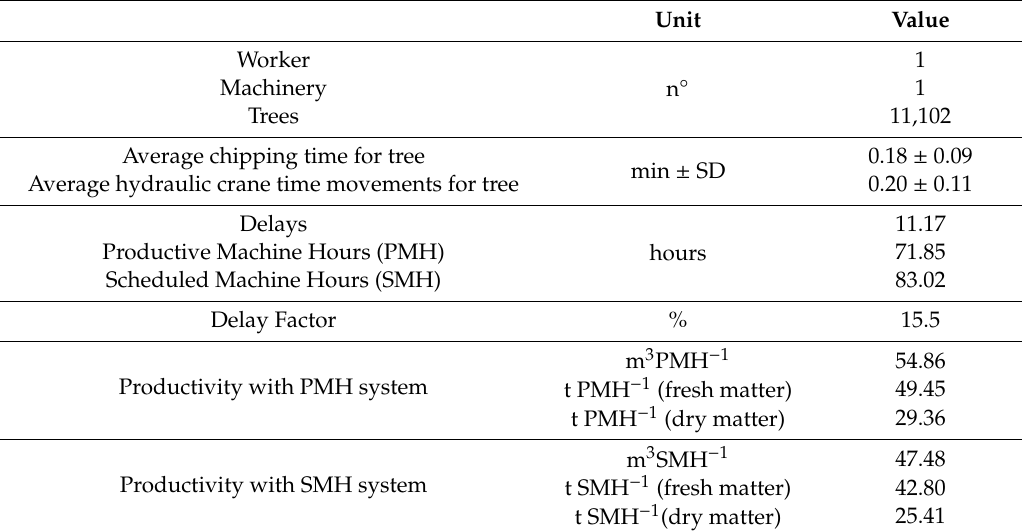
Figure 1. Nonlinear regression analysis for the two yarder lines, referred to the extraction time in relation to the extracted volume and extraction distance, with Savall carriage on the left and with Maxwald carriage on the right. Table 8. Time and productivity of chipping (average ± standard deviation).